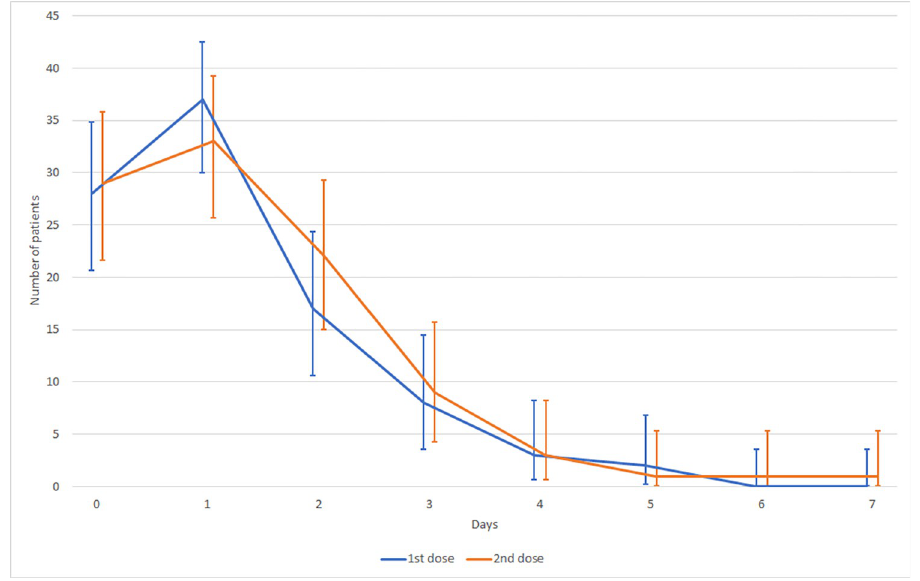
Fig 3. Local adverse reactions after SARS-CoV-2 vaccination—development in time.